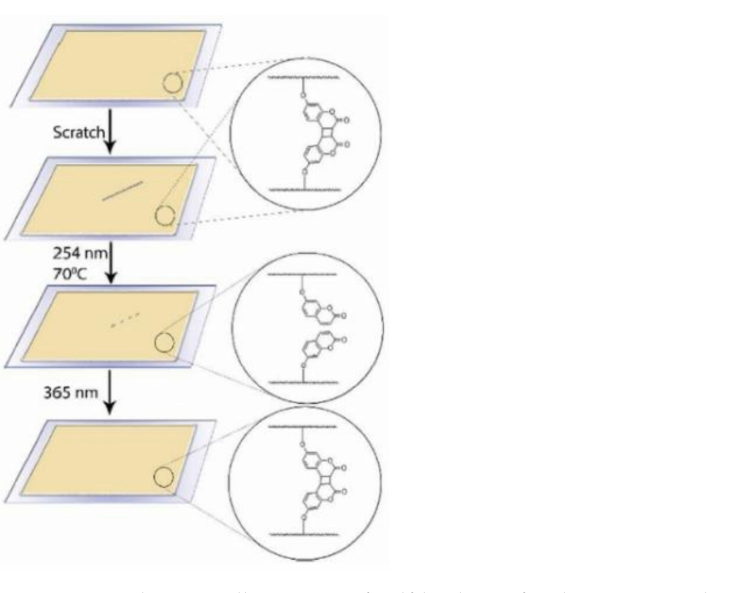
Figure 33. Schematic illustration of self-healing of polymer networks based on the reversible photodimerization of coumarin. Republished with permission of the Royal Society of Chemistry, from [179]; permission conveyed through Copyright Clearance Center,